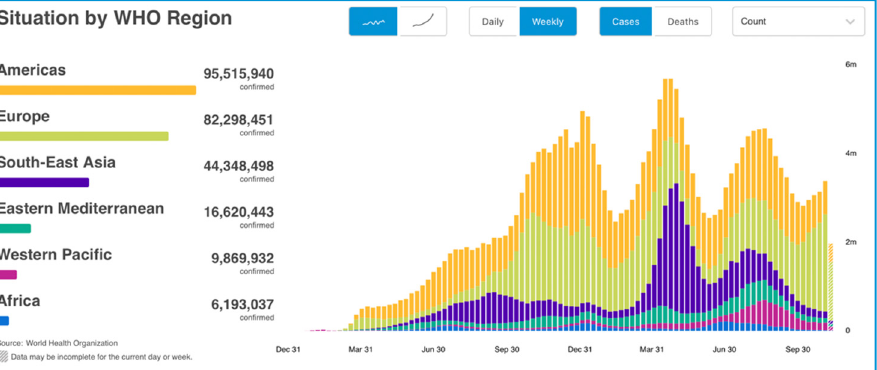
Figure 1. COVID-19 cases reported weekly by WHO Region, and global deaths, as of 18 November 2021 tried by World Health Organization 2021.